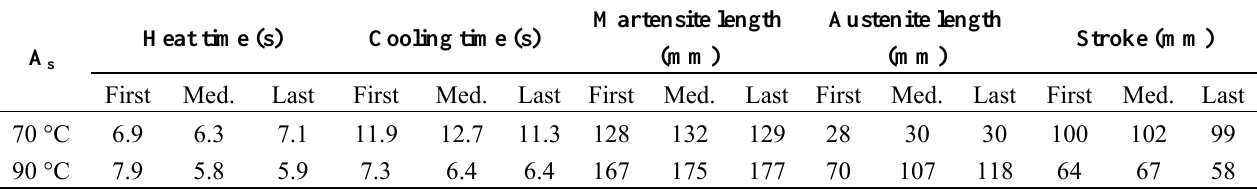
Table 9. The averaged first, median and last values for the springs with 90 °C austenitic starting temperature.